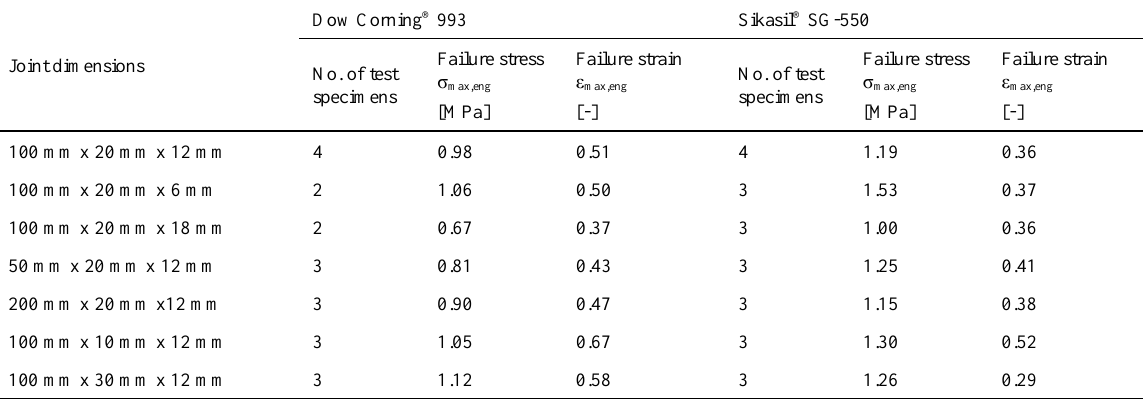
Table 4: Mean values for failure engineering stress and corresponding engineering strain from the tensile tests on glass-stainless steel joints.